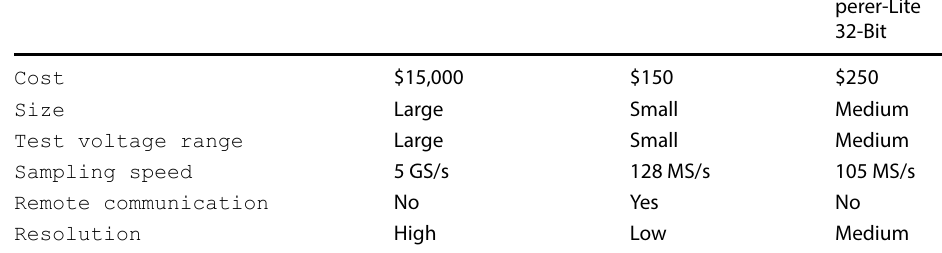
Table 1 Comparison between traditional side-channel analysis systems and